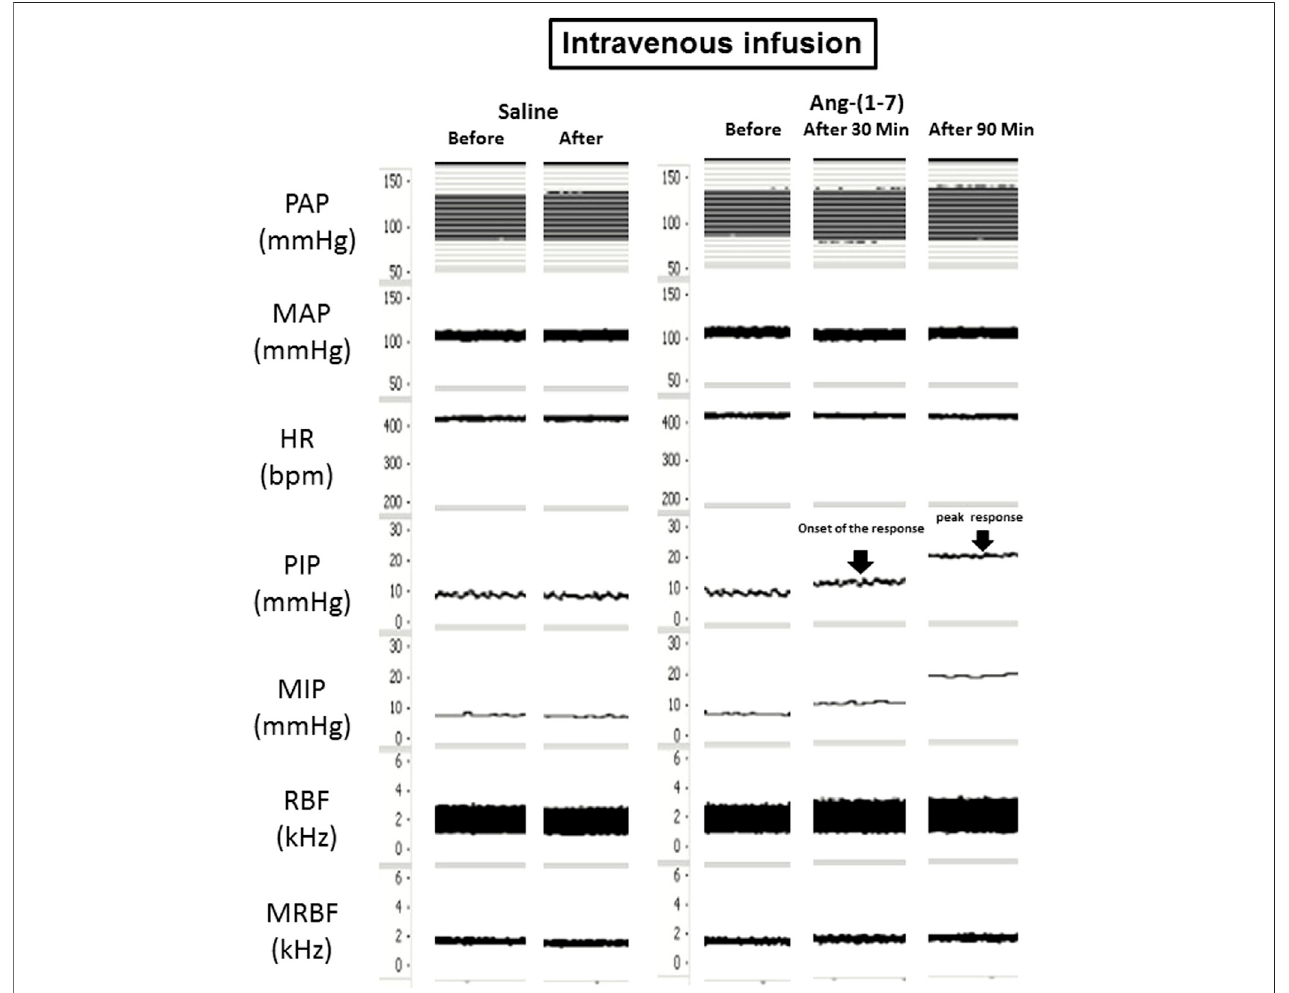
FIGURE2| Tracingsshowingthebaselinepulsatilearterialpressure(PAP,mmHg),meanarterialpressure(MAP,mmHg),heartrate(HR,bpm),pulsatileintravesical pressure (PIP, mmHg), mean intravesical pressure (MIP, mmHg), renal blood fl ow (RBF, kHz) and mean renal blood fl ow (MRBF, kHz) and the responses induced by intravenous administration of angiotensin-(1 – 7) (0.24 μ g/kg) or saline.